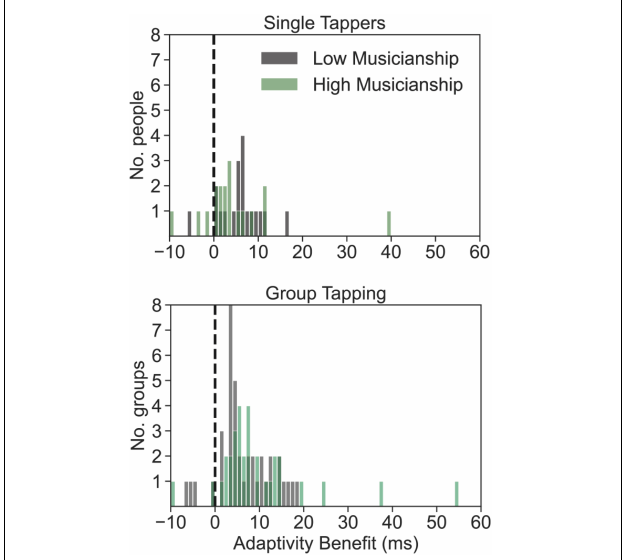
FIGURE 6 | The enhanced tapping accuracy (in ms) that participants experienced during optimally adaptive metronome conditions, as a function of their musical sophistication, in single and group tapping experiments. Participants (top panel) or groups (bottom panel) scoring in the top half of musical sophistication (Gold-MSI) are plotted in green, while those in the bottom half (low musical sophistication) are plotted in gray. Positive values indicate the extent to which participants’ SD asynchrony improved. Negative values indicate the opposite (that participants or group became worse at optimal adaptivity).